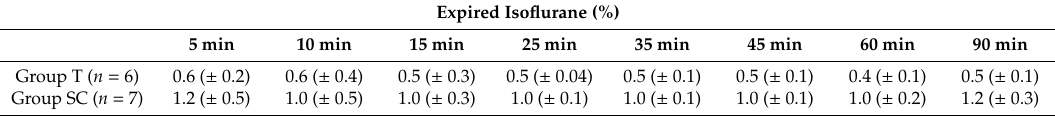
Table 1. Mean ( ± standard deviation) concentration of expired isoflurane during administration of isoflurane after an initial dose of medetomidine of 0.05 mg / kg SC followed by a continuous medetomidine infusion of 0.15 mg / kg / h SC (Group T) or a medetomidine dose of 0.05 mg / kg SC (Group SC). The delivery of isoflurane was adjusted as necessary to maintain an adequate depth of anaesthesia, as assessed by response to toe pinch, heart rate, respiratory rate and expired carbon dioxide concentration. Only results for the first 90 min are shown. Expired Isoflurane (%) 5 min 10 min 15 min 25 min 35 min 45 min 60 min 90 min Group T ( n = 6) 0.6 ( ± 0.2) 0.6 ( ± 0.4) 0.5 ( ±